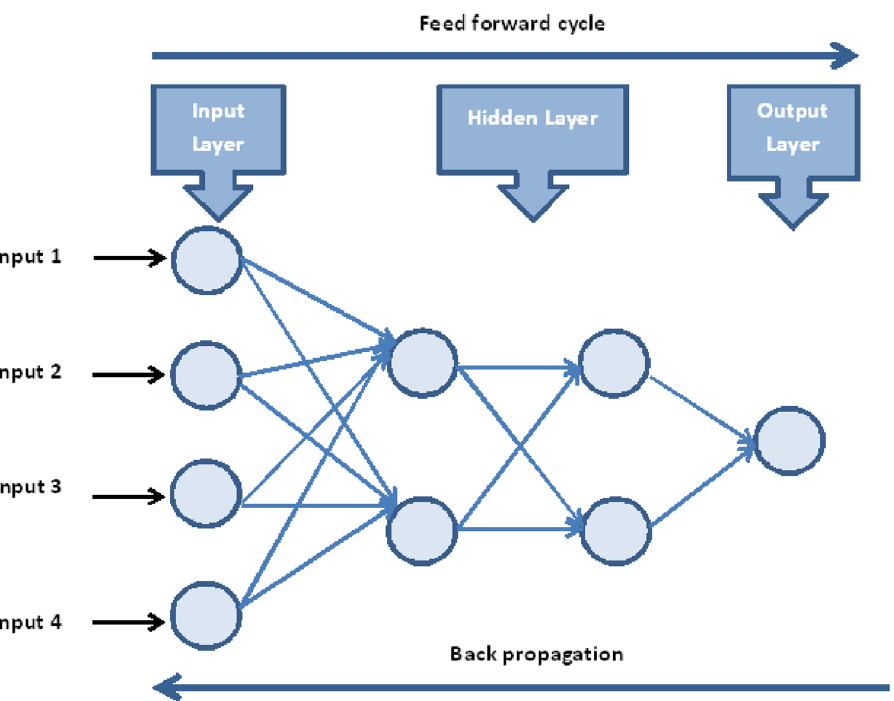
Figure 19. Configuration topology for MLP